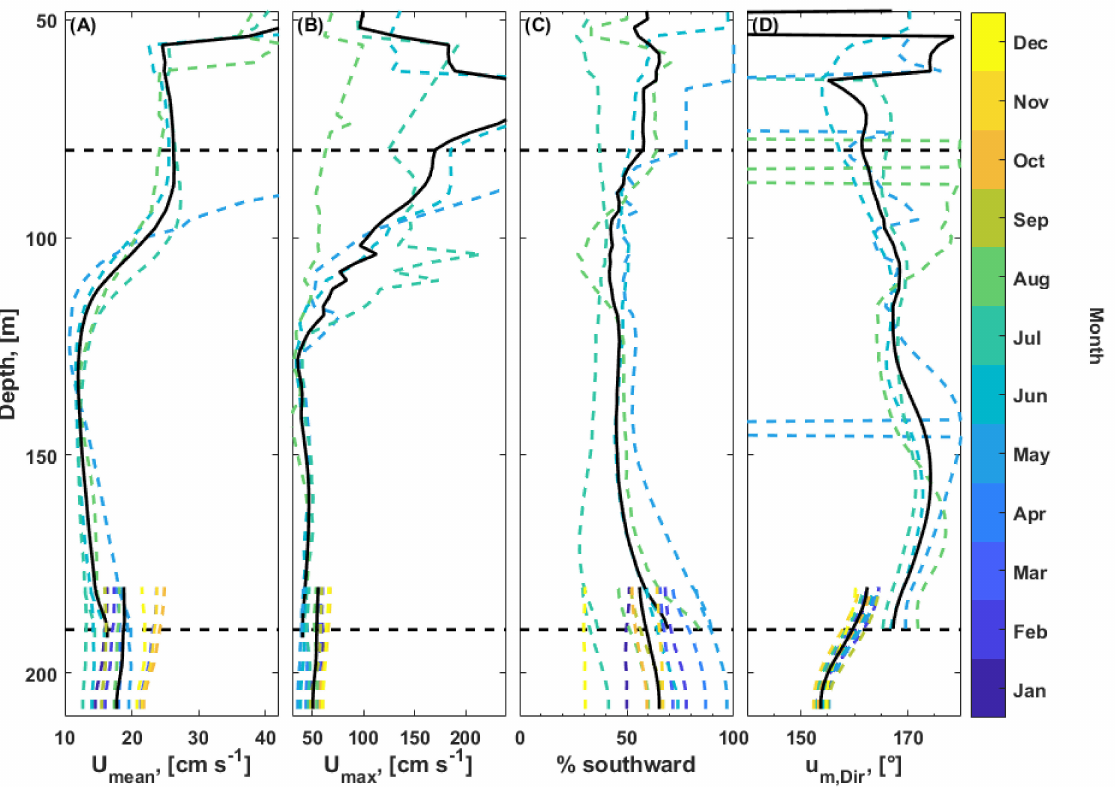
Figure 9. Monthly water column values for ( A ) mean flow speed, ( B ) maximum flow speed, ( C ) percentage of southward flow (90–270 ◦ ), and ( D ) direction of most energetic fluctuations at SLM (depths 180–210 m) and MLM (depths 50–190 m) lander positions. The thick black line marks the mean of the recorded period. The dashed horizontal lines represent the definition for surface waters (<80 m) and the depths of the living CWCs at Nakken (>190 m). The values were calculated from a 1 h running median to avoid